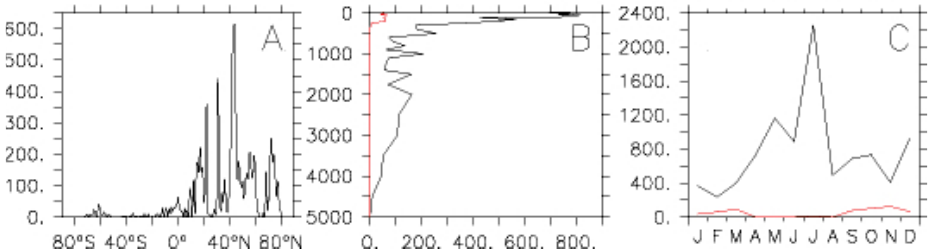
Figure 1. Number of grid points with data, as a function of (A) latitude, (B) depth, and (C) time. Red: Southern Hemisphere, black: total.